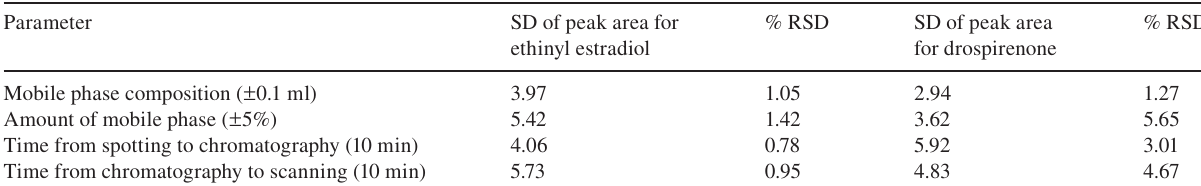
Table 2 Robustness testing (n = 6).